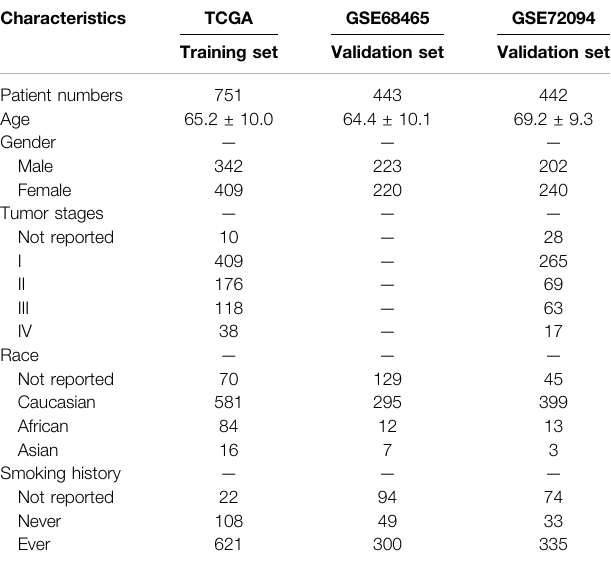
TABLE 1 | Clinicopathological characteristics of LUAD patients from the training and validation sets.